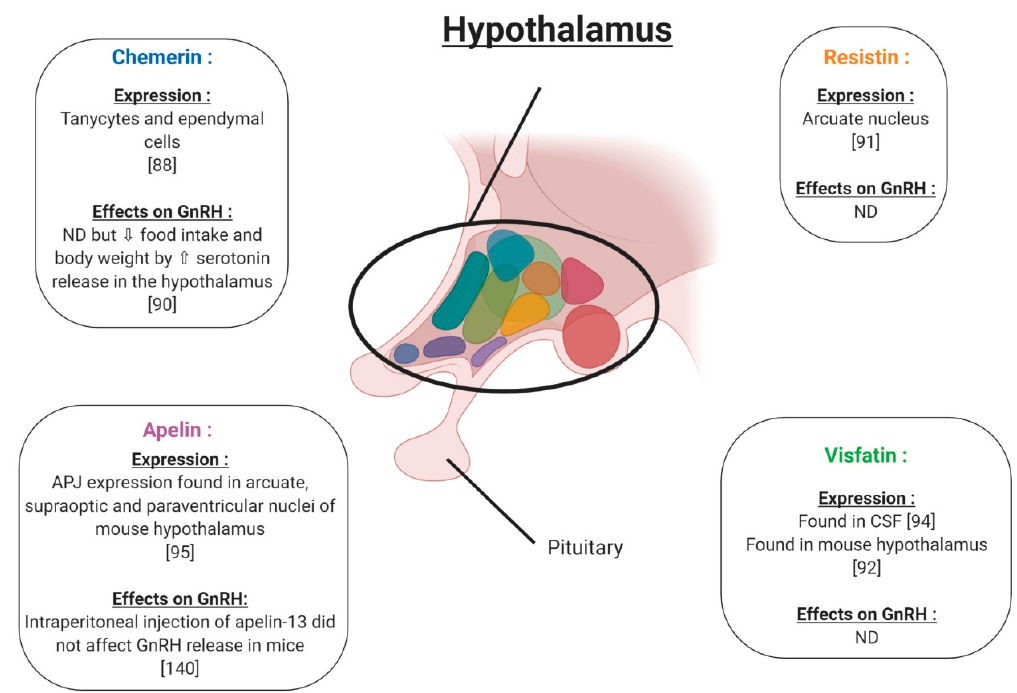
Figure 6. Expression and effects on GnRH (Gonadotropin-Releasing Hormone) release of chemerin, visfatin, resistin and apelin in hypothalamus. ⇧ Increase/stimulation. ⇩ Decrease/inhibition. ND: not determined. CSF: cerebrospinal fluid.